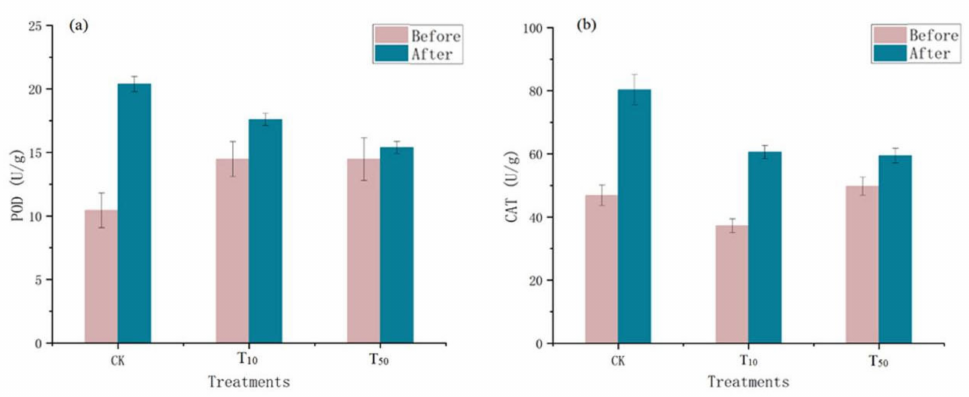
Figure 2. Changes in peroxidase ( a ) and catalase ( b ) in wormcasts before and after vermicompost. CK, T 10 , and T 50 represent treatment groups with 0, 10, and 50 mg/kg arsenic added,